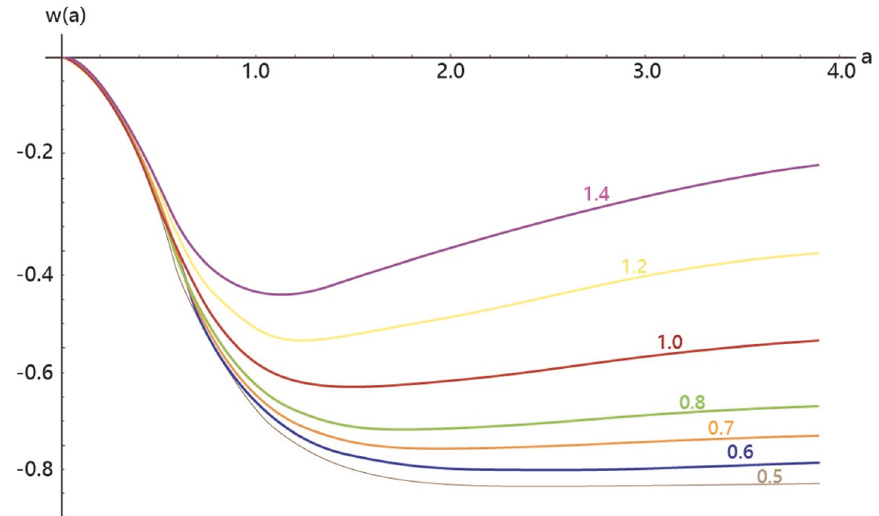
Figure 2 . This plot shows a comparison of the total cosmic equation of state w ( a ) = w DE ( a ) (cid:2) (cid:10) DE ( a ) for 0 : 5 (cid:20) (cid:21) (cid:20) 1 : 4 for scalar (cid:12)eld dark energy models with exponential potentials, as motivated by considerations of Swampland-based constraints